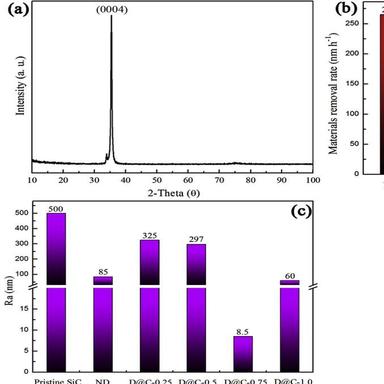
(a) XRD of the polished 4H–SiC wafer with D@C-0.75, (b) MRR of the pristine ND and D@C-x, (c) Ra of the 4H–SiC wafer before and after polishing using pristine ND and D@C-x.